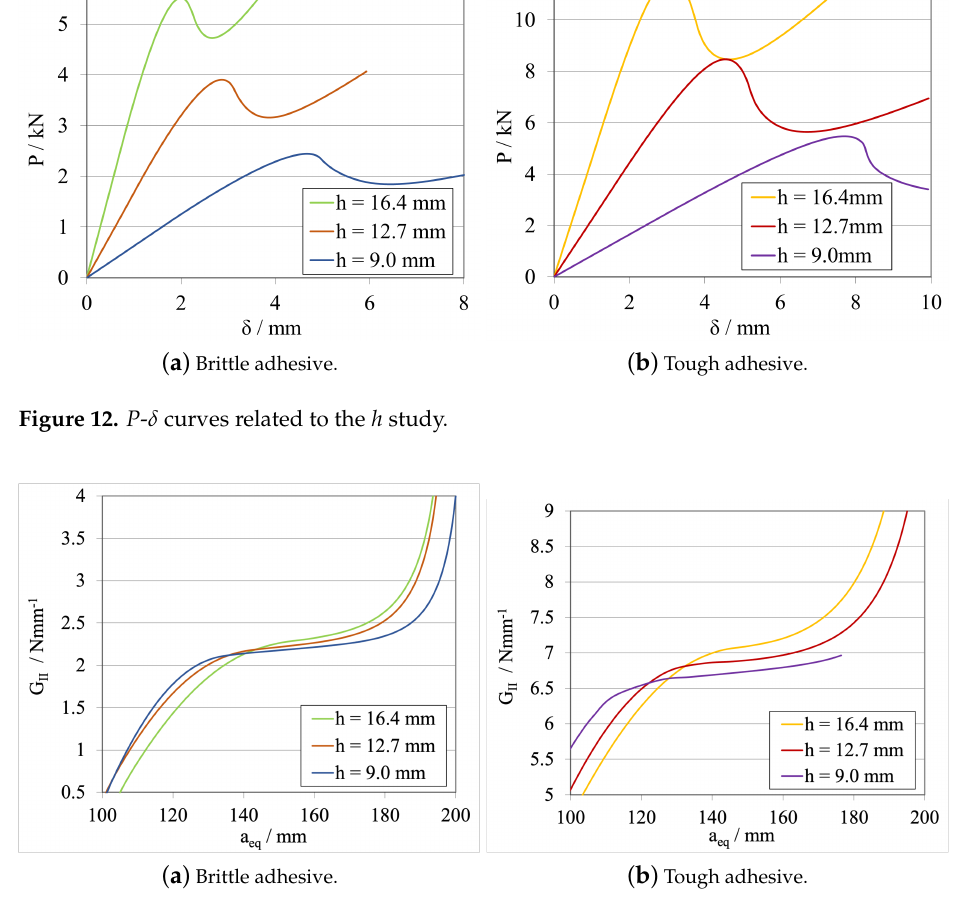
Figure 13. R-curves related to the h